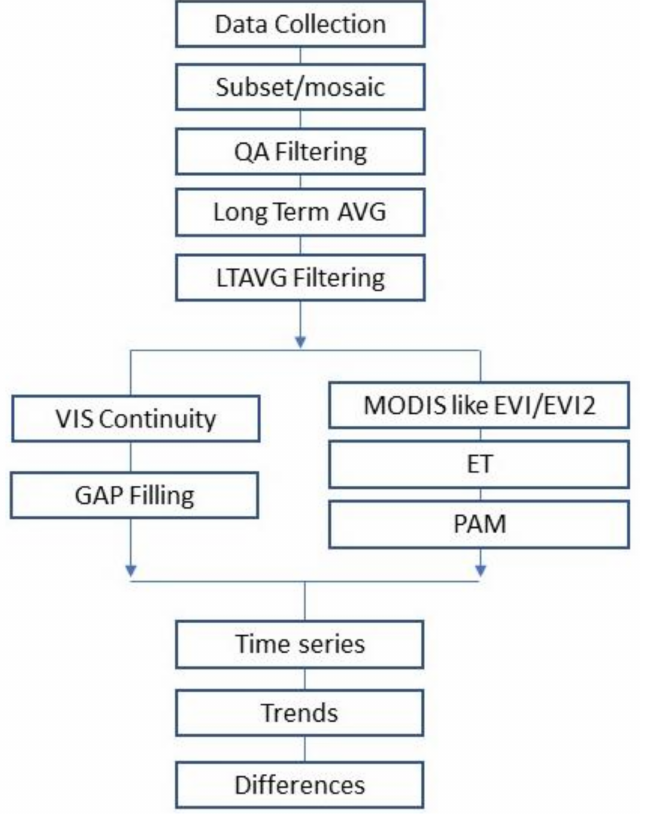
Figure A4. Flow chart of